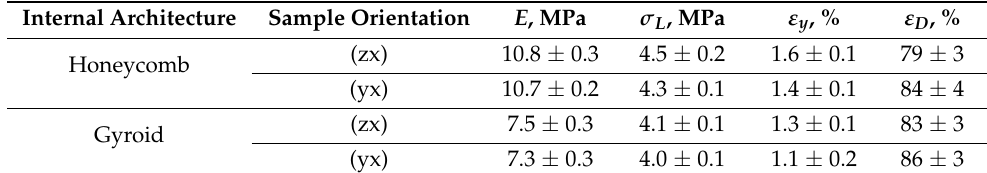
Table 3. Mechanical properties of lattice flexible TPU. Compression test.